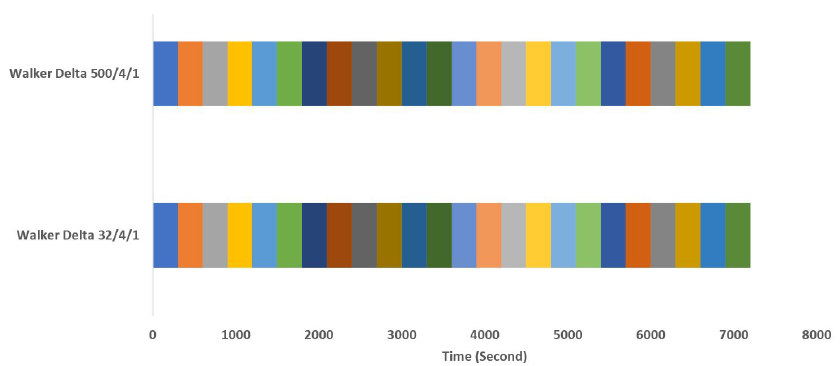
Figure 13. ISL duration of the two constellations.